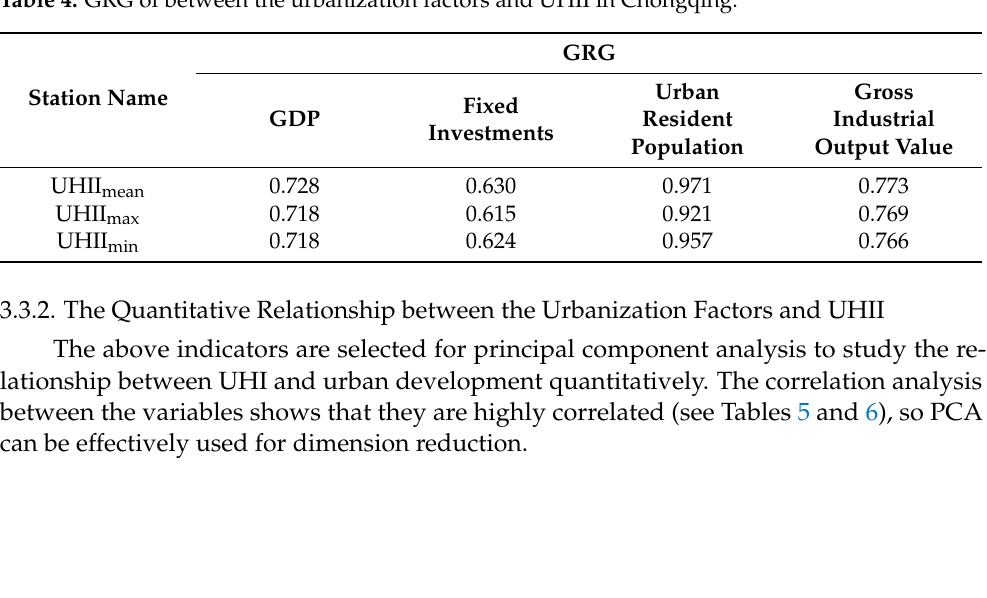
Figure 11. Relationship between comprehensive UHII index and the comprehensive urbanization index in Chongqing. Data for each year are indicated with black dots. Table 4. GRG of between the urbanization factors and UHII in Chongqing.